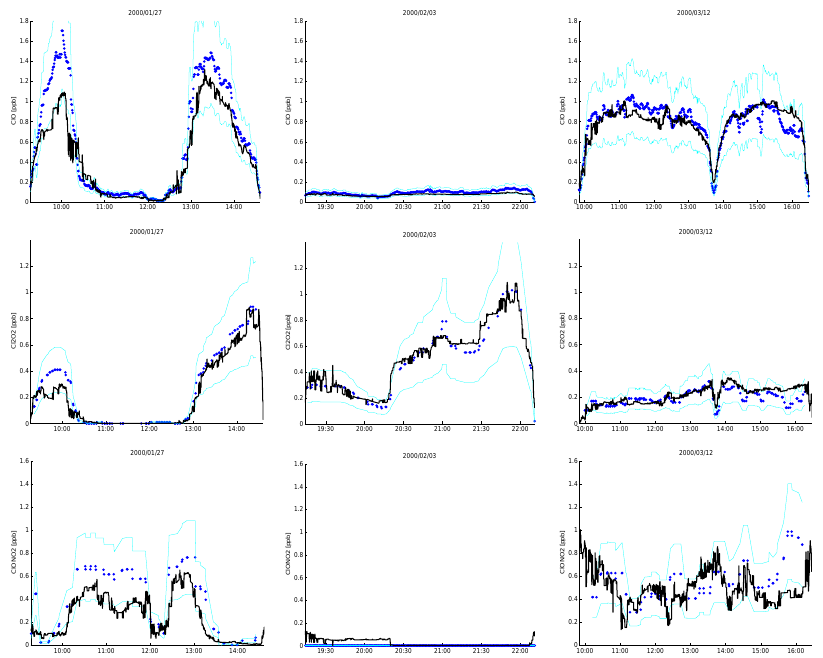
Fig. 8. ClO (top), Cl 2 O 2 (middle) and ClONO 2 (bottom) as a function of flight time (UTC) from measurements of selected ER-2 flights (27 January, 3 February, 12 March) (blue dots, cyan lines show 2 σ accuracy) compared to modeled values (black lines).